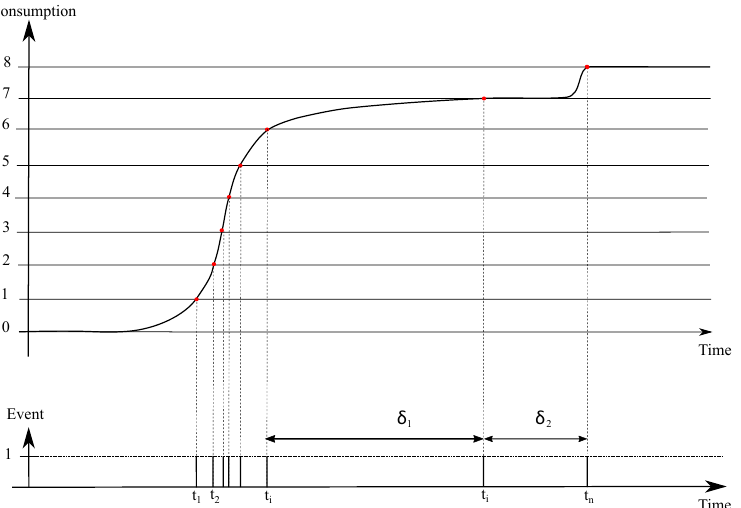
Figure 3. Example of a cumulative load curve (LC) which shows the raw data by red dots unevenly spaced in time as recorded and transmitted by a smart sensor (the black curve is an interpolation) and with results from the sequence of events corresponding to each consumed